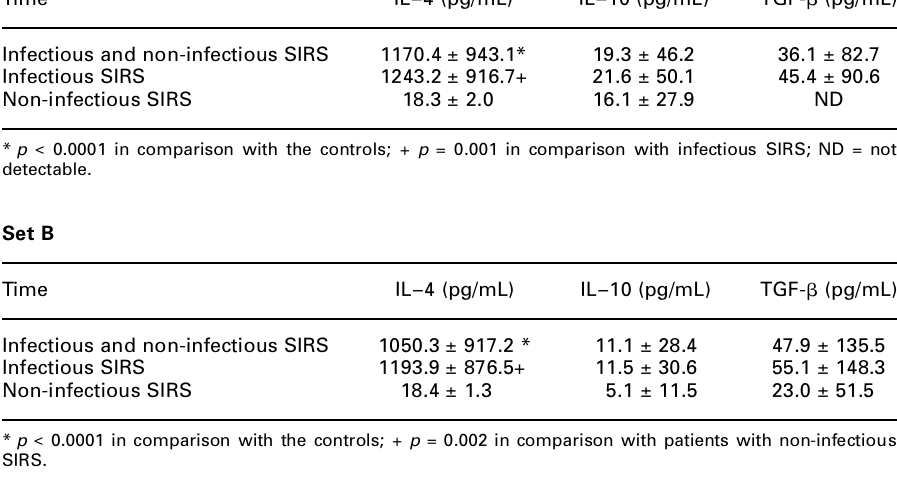
clinical criteria for SIRS. 1 Thirty-eight patients (mean age: 52.5 ± 21.5 years) had infective SIRS, caused in seven patients by gram-positive infection, in six patients by gram-negative infection, in four by poly-